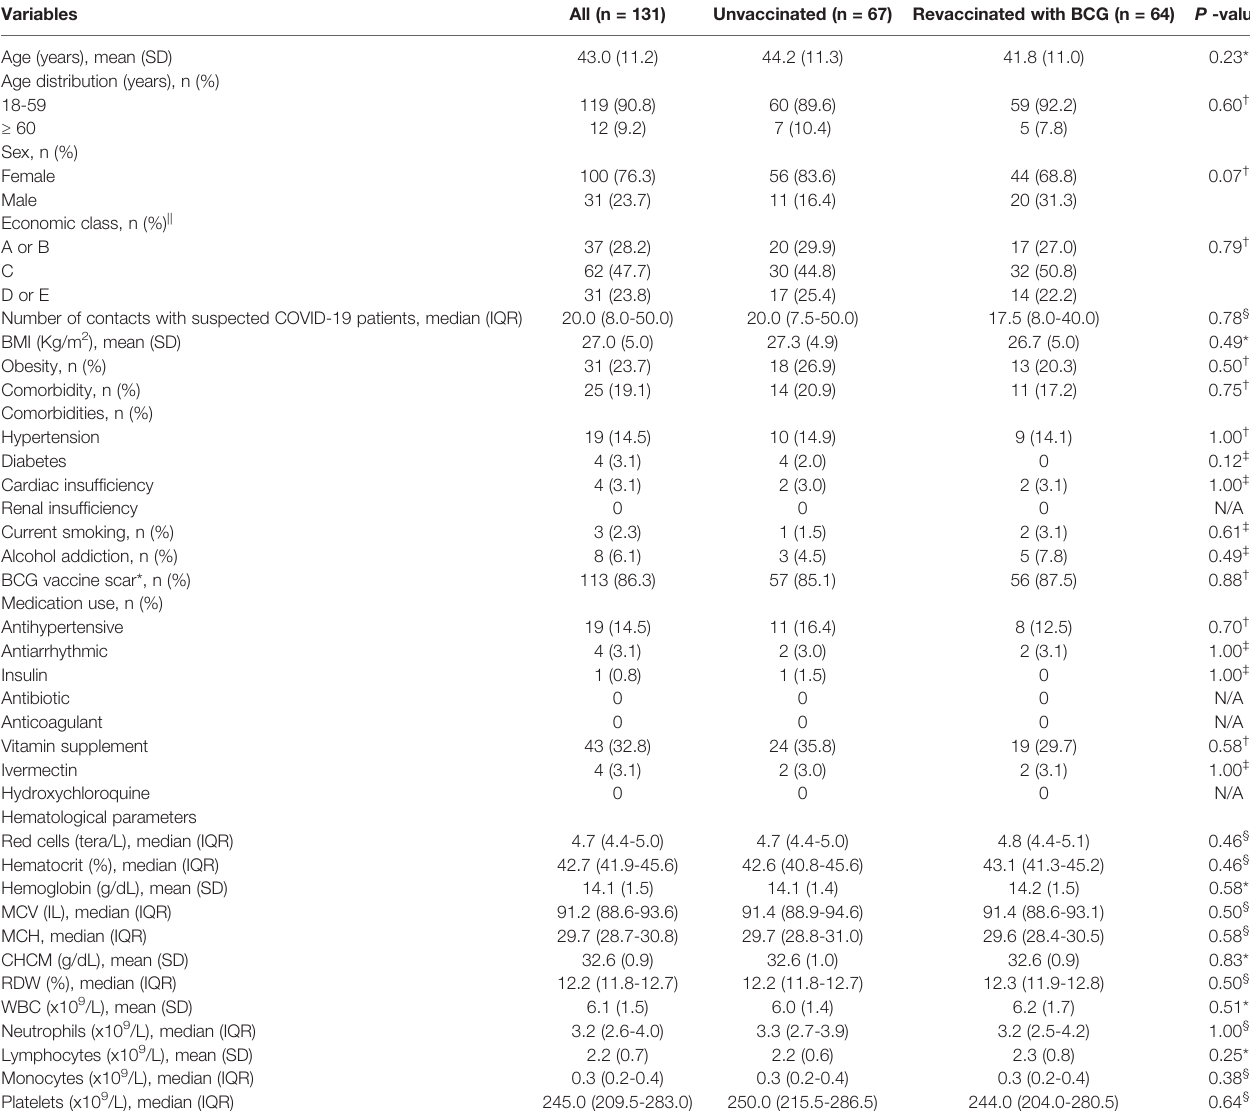
TABLE 2 | Baseline characteristics according to allocated group (Unvaccinated or revaccinated with BCG). Variables All (n = 131) Unvaccinated (n = 67) Revaccinated with BCG (n = 64) P